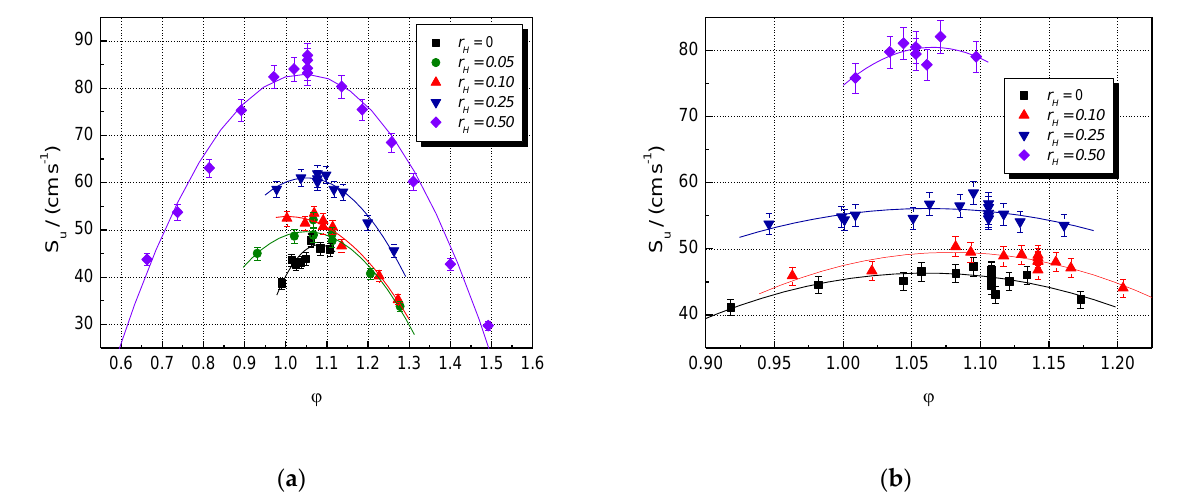
Figure 1. Experimental laminar burning velocities of single fuel–air and multifuel–air mixtures with various r H at ambient initial pressure and temperature: ( a ) CH 4 – H 2 – air; ( b ) NG – H 2 – air mixtures (present data).